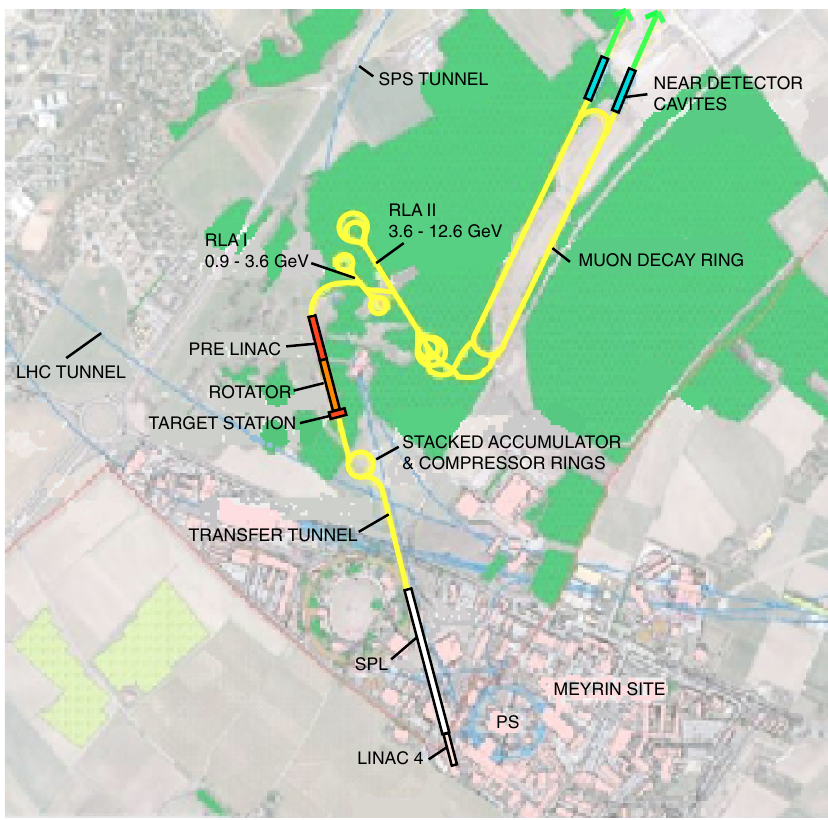
FIG. 3. Preliminary layout of the NF on the CERN site, with neutrino beams pointing at the Pyha¨salmi mine in Finland.